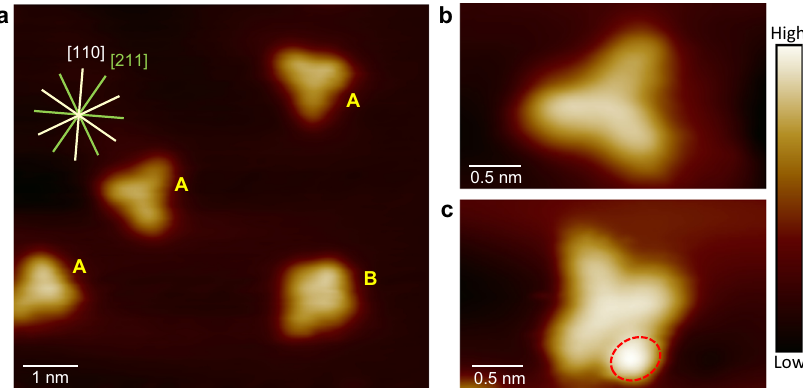
Fig. 2 | Imaging rare-earth complexes on Au(111). a An STM image shows indi- vidual [Eu(pcam) 3 X] 2+ complexes (labeled ‘ A ’ ) and [Eu(pcam) 3 X 2 ] + (labeled ‘ B ’ ) on Au(111) [V t = − 2.0V, I t =7.4×10 − 11 A, 5K]. b A zoom-in STM image of complex